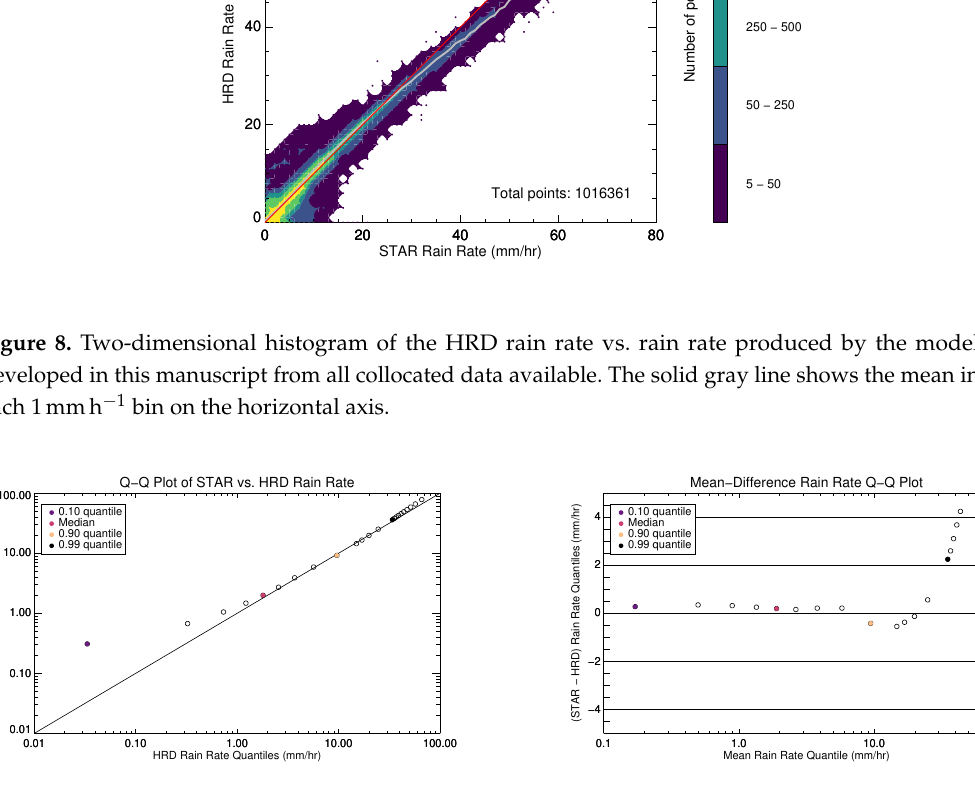
Figure 9. Rain-rate distribution comparisons between the STAR retrievals and the HRD retrievals from all collocated data available. The left panel shows a log-log quantile-quantile plot comparing the STAR and the HRD retrievals. The right panel shows the mean-difference plot of the same two datasets with only the horizontal axis shown in a logarithmic scale. The lowest quantile shown is the 10% quantile with the remainder increasing in 10% steps up to 90%, then in 1% steps up to 99%, then in 0.1% steps up to